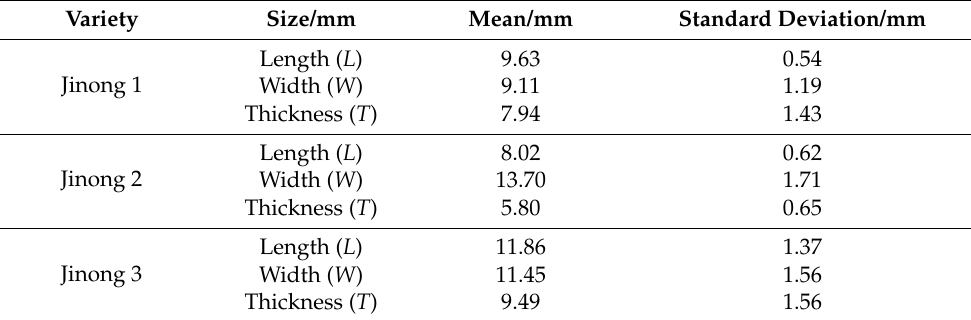
Figure 1. ( a – c ) Three varieties of Cyperus esculentus seeds [22]. Table 1. Cyperus esculentus average of tri ‐ axial dimensions and standard deviation [22].